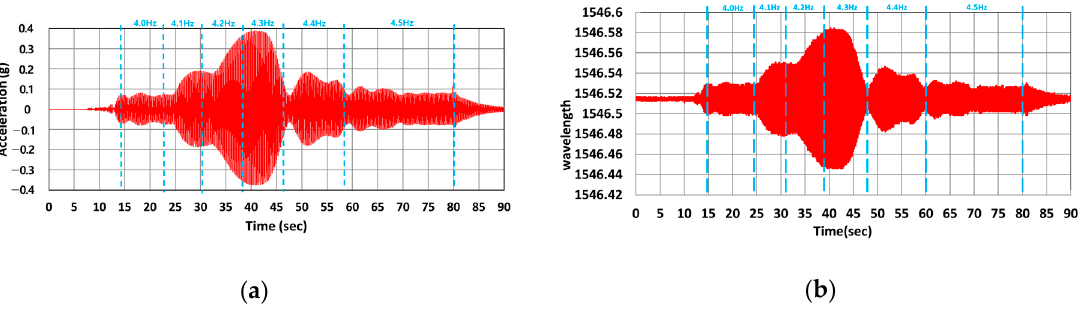
Figure 11. Dynamic test measurements: ( a ) Accelerometer data; ( b ) FBG data.